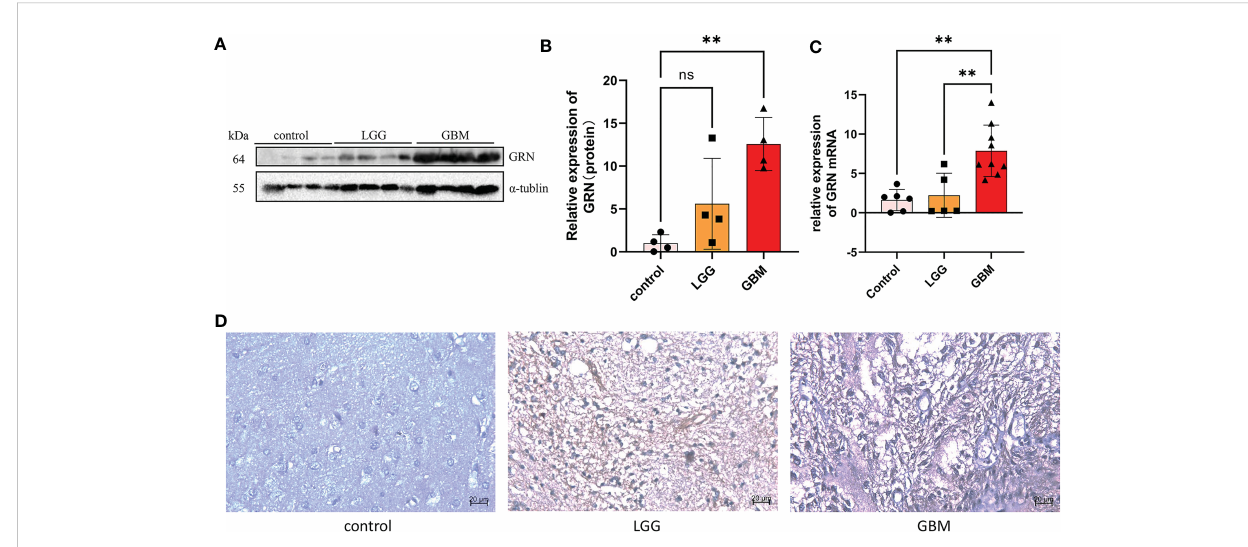
FIGURE 8 GRN is upregulated in GBM tissues. (A, B) Western blot was used to detect the expression of GRN in control and tumor of GBM patients (n = 4). (C) RTqPCR analysis of the different GRN expressions in gliomas and adjacent normal tissues. (D) IHC staining of GRN protein expression in gliomas and adjacent normal tissues. **p< 0.01. Scale bar, 20µm. ns, not signi fi cant.